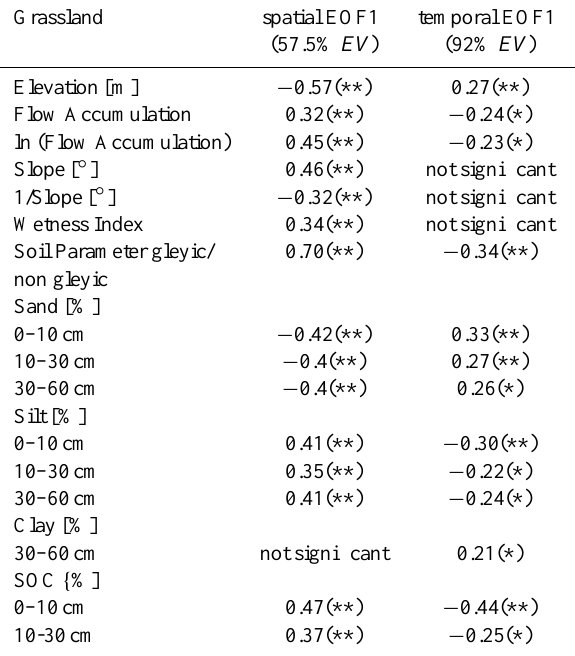
Table 1. Pearson correlation coefficients between EOFs and topo- graphic and soil parameters for the grassland test site; Curvature H/V, % Clay 0–10cm, 10–30cm and % SOC 30–60cm were